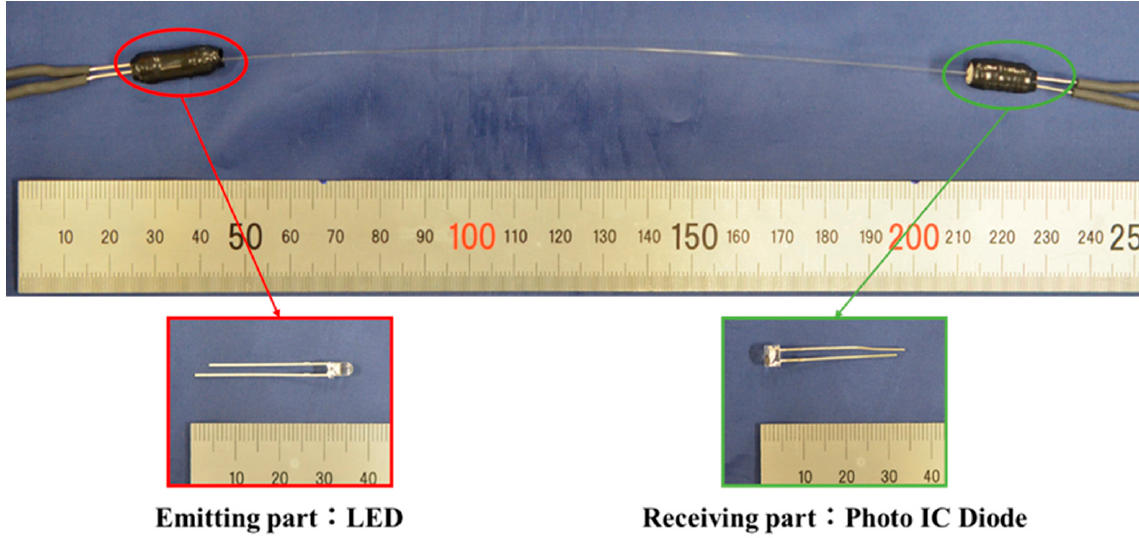
Figure 6. Appearance and structure of the step-index multimode optical fiber sensor.